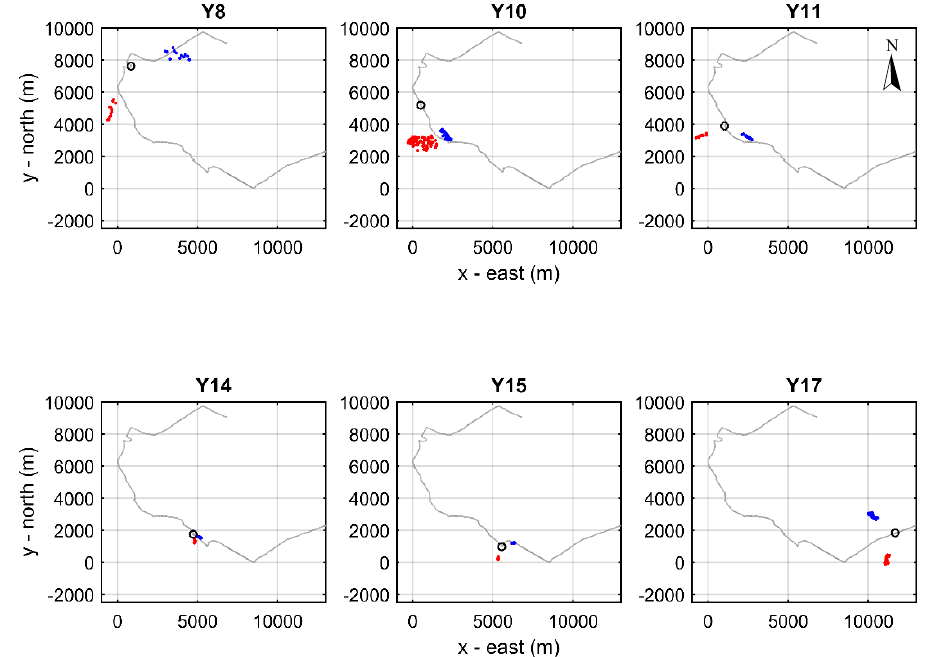
Figure 21. Localization results for source range (from front hydrophone) and depth for sperm whale Y during stations Y8, Y10, Y11, Y14, Y15, and Y17. The error bars about the estimated means ( ◦ ) indicate the posterior RMS errors.